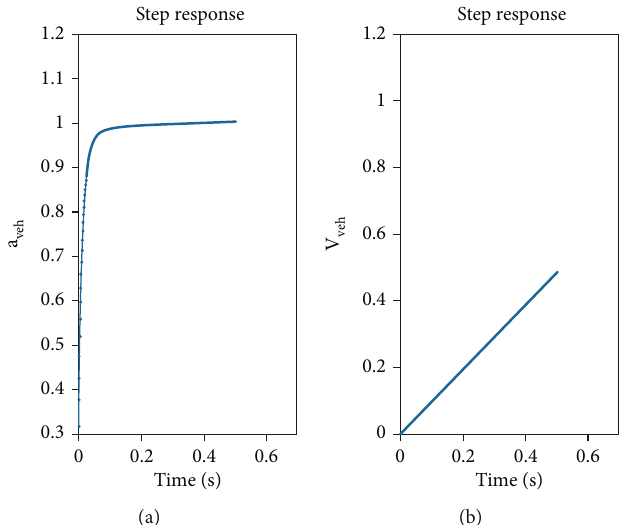
Figure 18: Vehicle acceleration (a) and speed (b) responses, respectively, in PID-CHR (20%) (3).